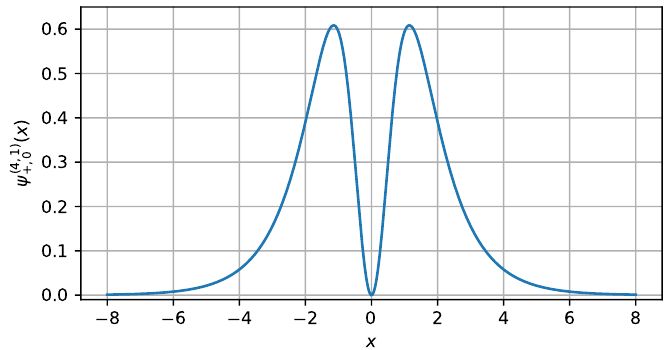
Figure 2 . Wave function of the bound state of V eff ( x ) = V PT , + ( x ; 4 , 1)